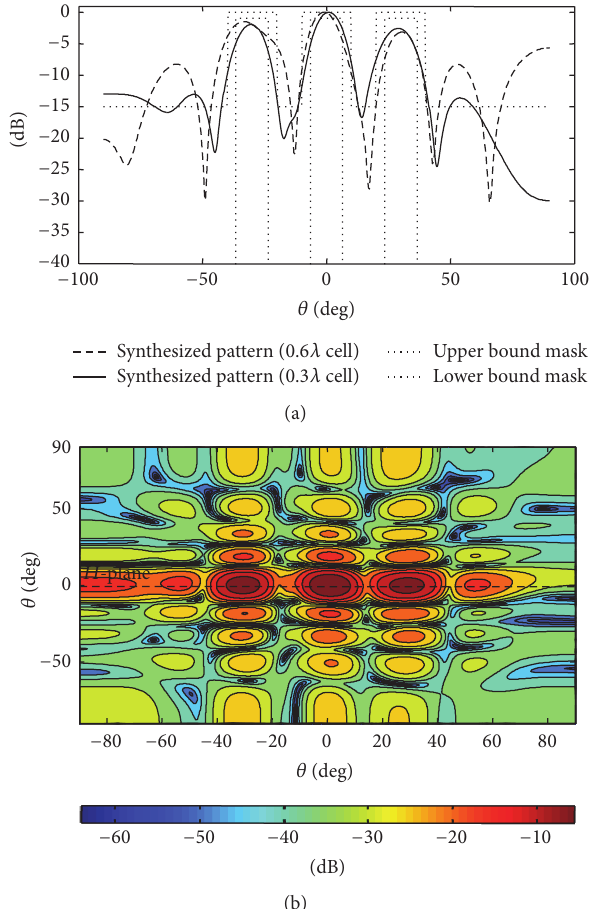
Figure 24: Design #4 : (a) synthesized 𝐻 -plane array factor; (b) synthesized 𝐸 -field contour plot.